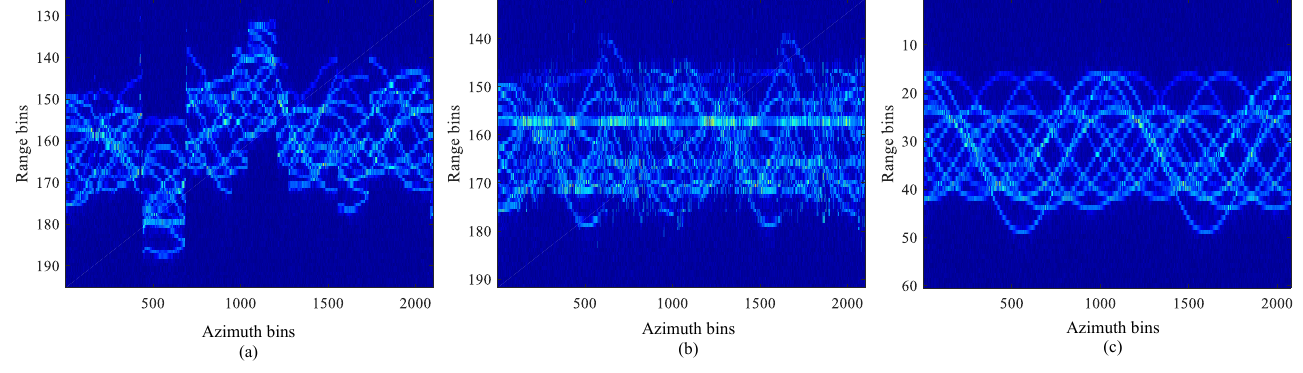
Figure 14. Profile of echo signal after envelope alignment. ( a ) Envelope alignment result with adjacent correlation method. ( b ) Envelope alignment result with average range envelope correlation method. ( c ) Envelope alignment result result with the proposed